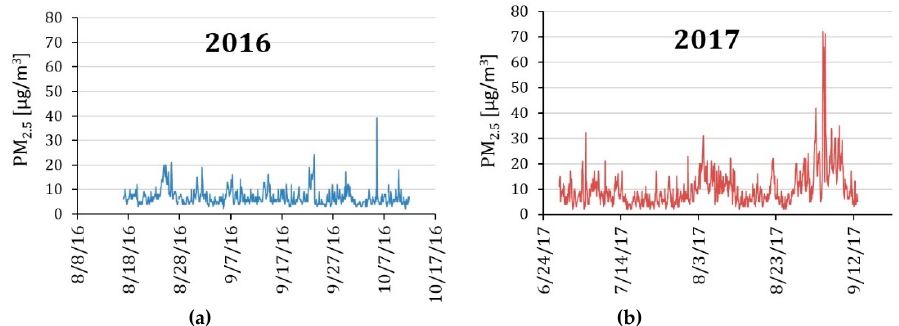
Figure 3. Time series data of particulate matter (PM 2.5 ) concentration measurements made at Colorado